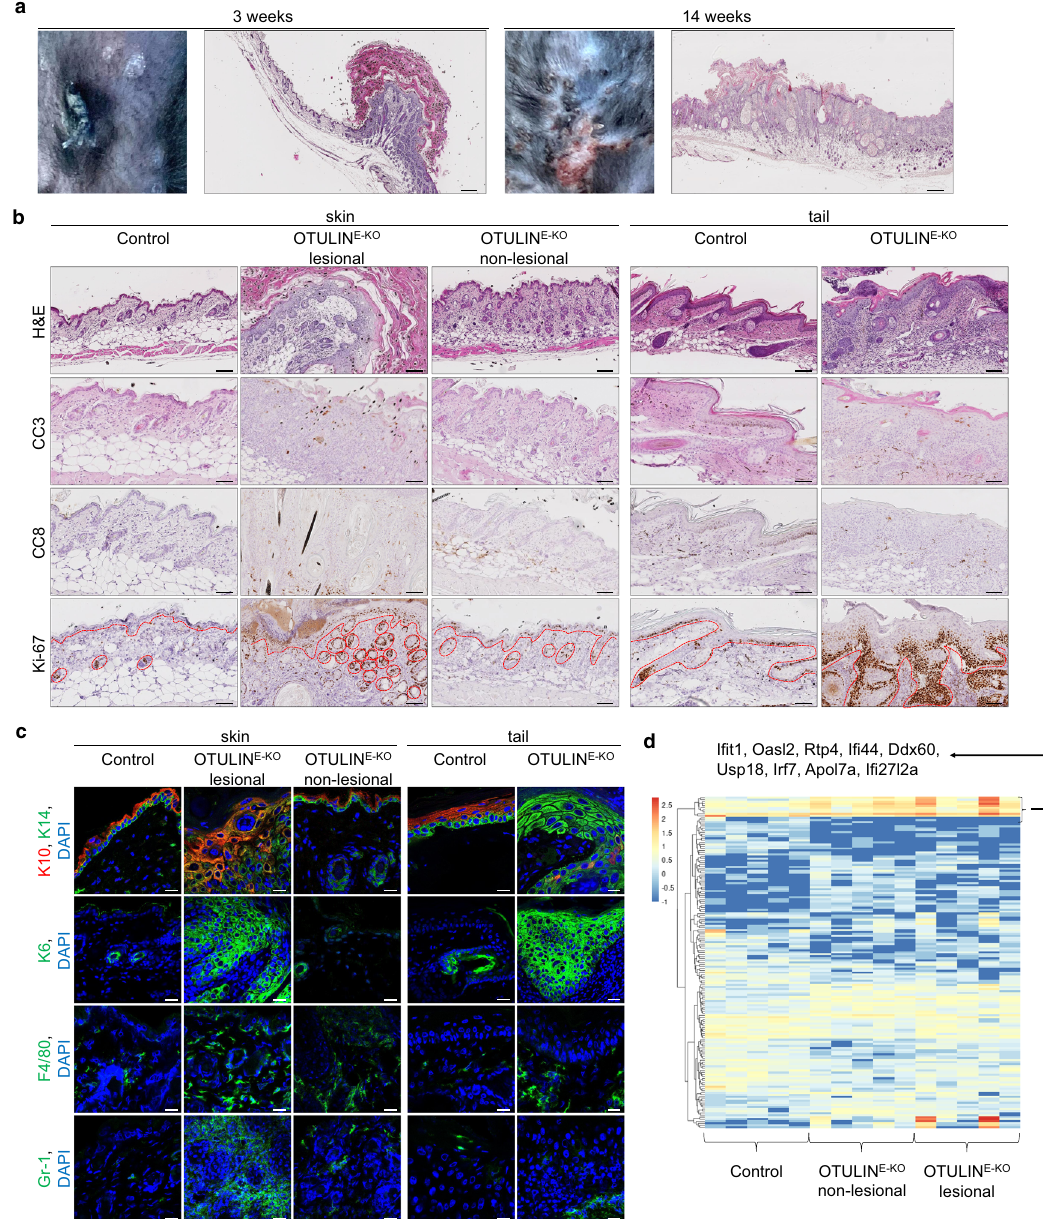
Fig. 1 Mice lacking OTULIN in keratinocytes develop skin in fl ammation. a Photographs of lesional skin from OTULIN E-KO mice at the age of 3 and 14 weeks and representative images from skin sections from 3- or 14-week-old mice from OTULIN E-KO , stained with haematoxylin and eosin (H&E). Images shown are representative of OTULIN E-KO mice ( n = 25). Scale bars: H&E = 200 μ m. b Representative images of skin sections from 3-week-old mice of the indicated genotypes, stained with H&E ( n = 10) or immunostained with antibodies against cleaved caspase 3 (CC3) ( n = 6), cleaved caspase 8 (CC8) ( n = 6) or Ki67 ( n = 6). The epidermis in the sections stained for Ki-67 is indicated by a dotted line, arrows point to hair follicles. Scale bar H&E = 100 μ m; CC3, CC8, Ki-67 = 50 μ m. c Representative images of skin sections from 3-week-old mice of the indicated genotypes, immunostained with antibodies against keratin 10 (K10), keratin 14 (K14) ( n = 6), keratin 6 (K6) ( n = 6), F4/80 ( n = 6) and Gr-1 ( n = 6) and counterstained with DAPI (DNA stain). Scale bars: K10, K14, K6 = 20 μ m; F4/80, Gr-1 = 30 μ m. d Heatmap of gene expression data of OTULIN E-KO lesional or non-lesional skin tissue compared to skin from littermate Otulin FL/FL control mice. Columns represent gene expression pro fi les from 3-week-old mice ( n = 5), showing genes with an absolute log2(FoldChange) of ≥ 1, and an uncorrected p value of ≤ 0.05. Uncorrected p values are used on purpose to include a maximal number of genes in the plot while excluding clearly irrelevant genes. The statistical test producing the p values is Wald test for the absence of differential expression, i.e. for a log2(FoldChange) of zero. It is computed by function nbinomWaldTest of the Bioconductor R package DESeq2, based on a negative binomial general linear model of the gene counts. Control mice include littermates that do not express K14-Cre . Source data for d are provided as a Source data fi